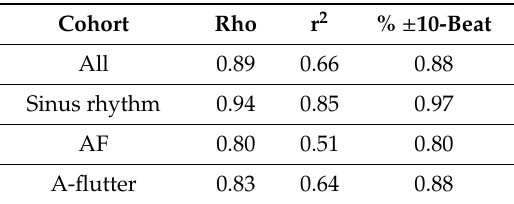
Table A1. Accuracy of heart rate measurements of the upper-arm wearable (PPG based) compared to ECG Holter recording. AF, atrial